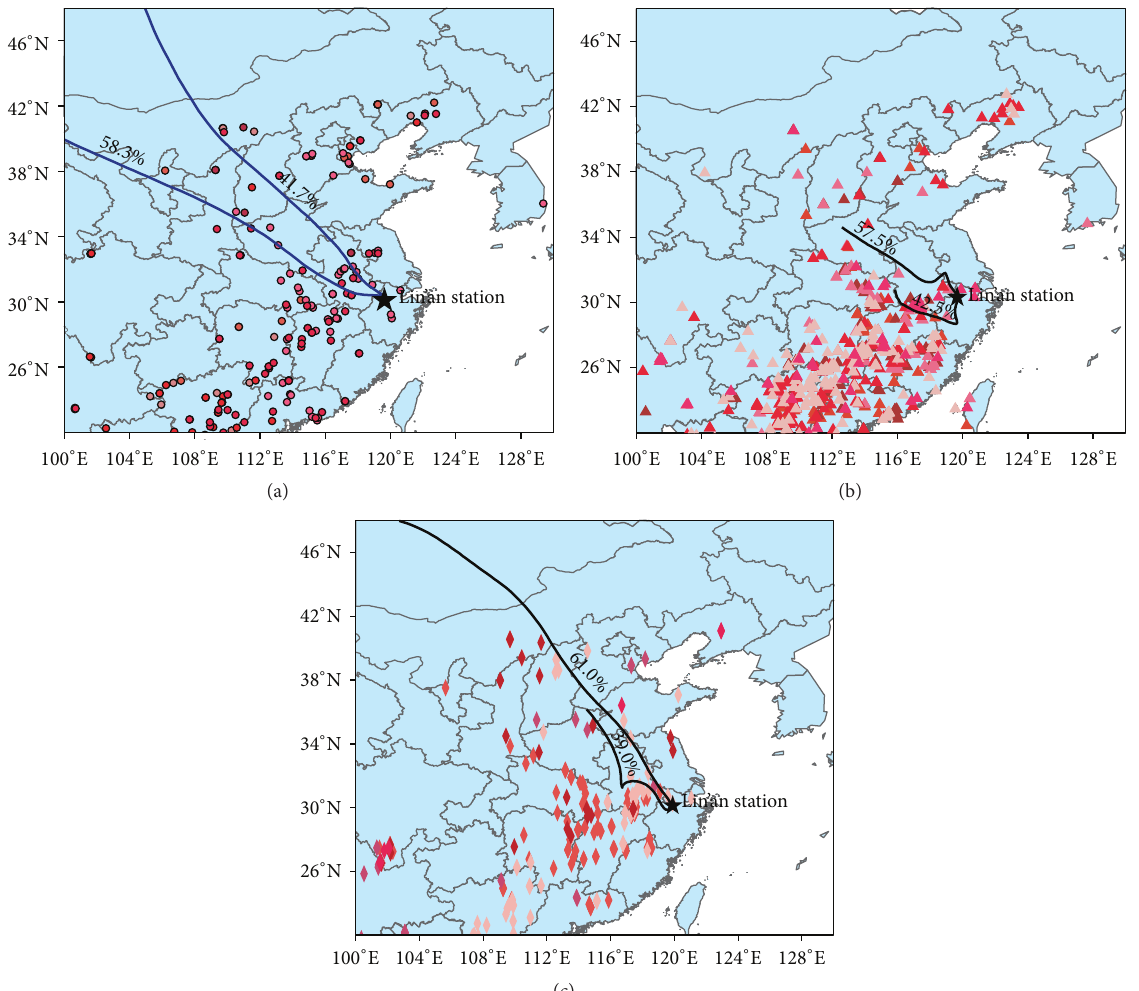
Figure 1: Active fire locations and 96 hr air mass backward trajectories of Lin’an station. (a) Prehaze period (25 ∼ 30 Nov. 2013), (b) haze period (4 ∼ 9 Dec. 2013), and (c) posthaze period (10 ∼ 14 Dec. 2013).